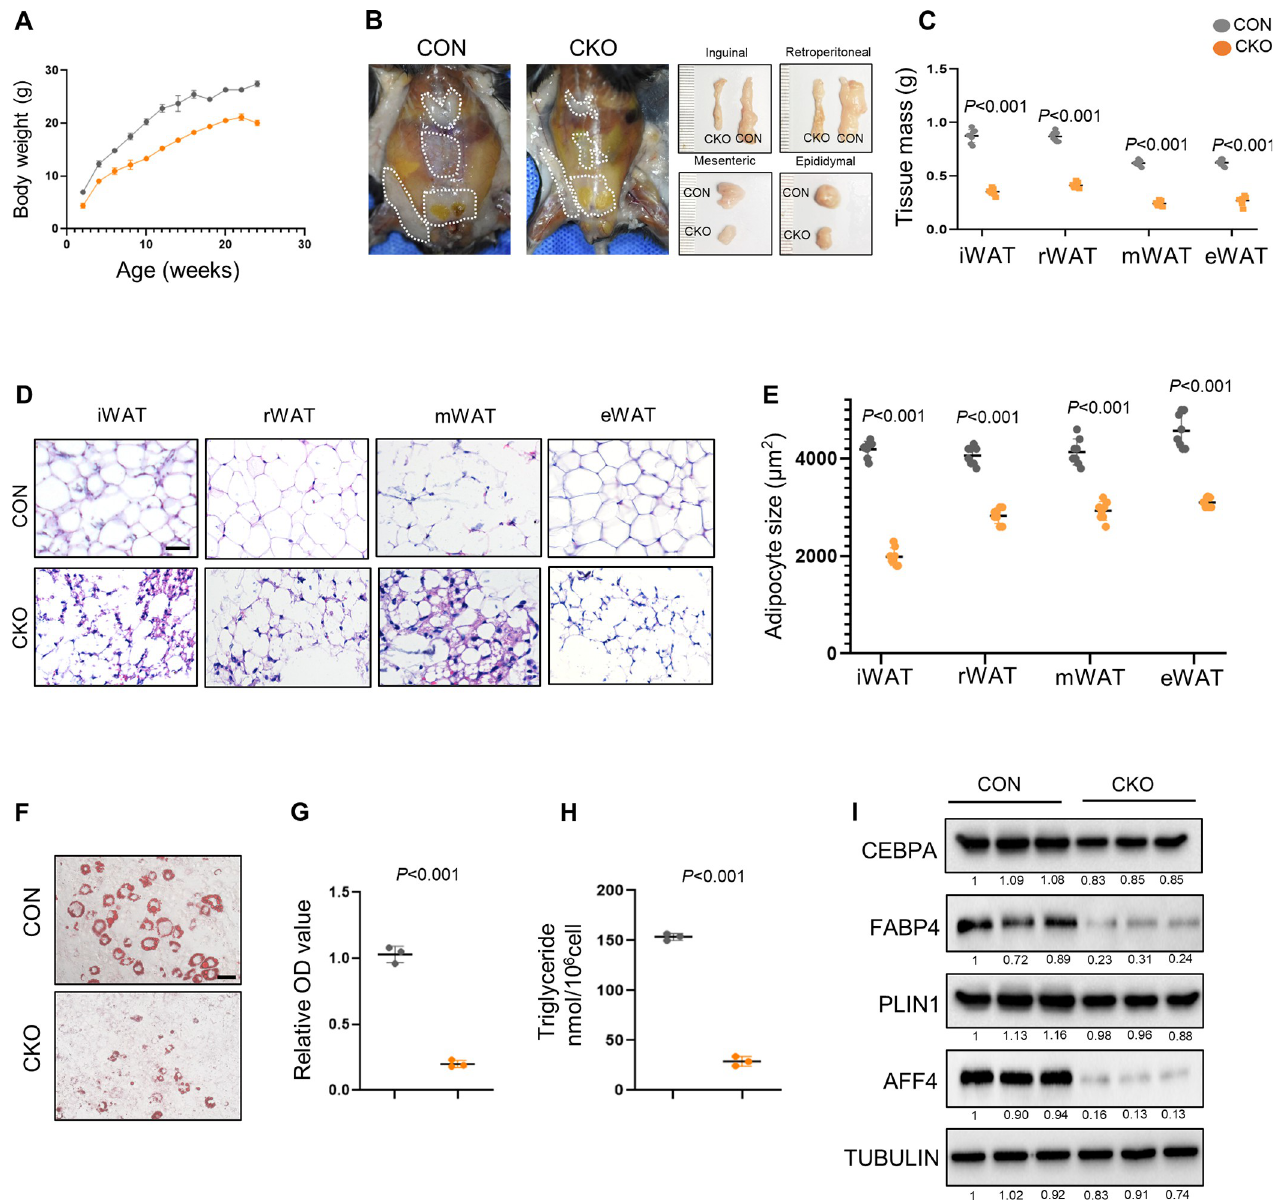
Fig 3. Conditional Aff4 knockout decreases fat mass in mice. (A-E) WAT formation was impeded in Aff4 knockout mice (A) Body weight of CON and CKO mice. n = 9. (B) Representative images of WAT from CON and CKO mice at 16 weeks of age. (C) Tissue weight of WAT is significantly lower in CKO mice. n = 8. (D) H&E staining of iWAT, rWAT, mWAT and eWAT in CON and CKO mice. Scale bar, 50 μ m. (E) Adipocyte size quantification in WAT. n = 8. (F-I) Adipogenic differentiation of primary preadipocytes. (F) Representative images of oil red o staining. Scale bar, 25 μ m. (G) Quantitative analysis of oil red o staining, absorbance at 518 nm. n = 3. (H) Triglyceride quantification. n = 3. (I) Western blot of preadipocytes obtained from CON and CKO mice. Each lane corresponds to lysates from one mouse. All quantified data are presented by as mean ± SD. The P values were calculated by two-tailed Student’s